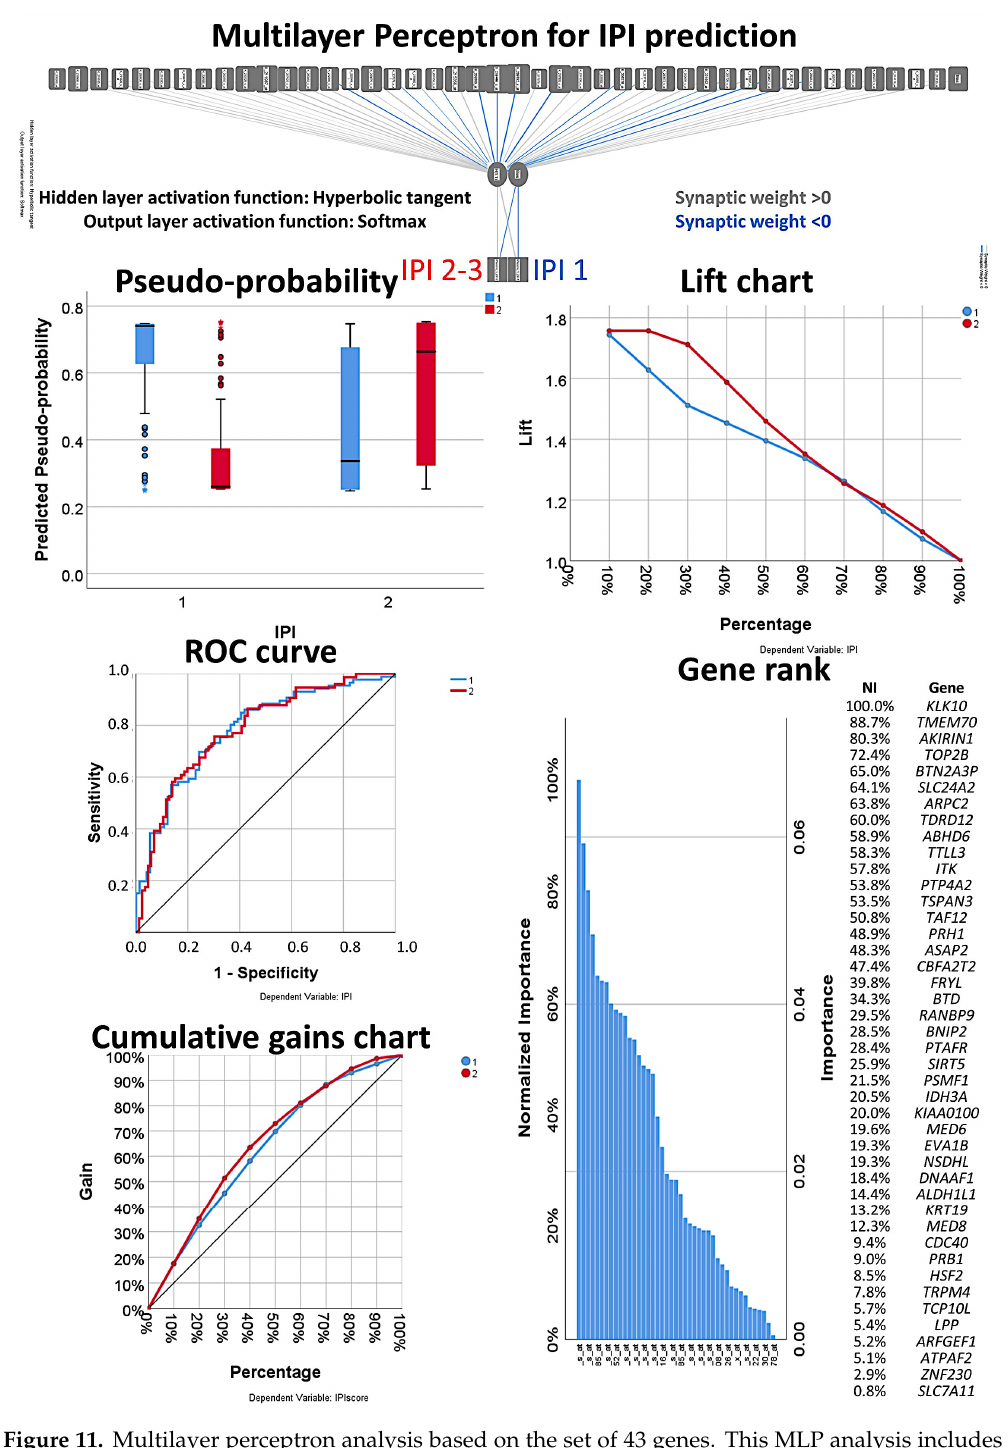
Figure 11. Multilayer perceptron analysis based on the set of 43 genes. This MLP analysis includes only the final set of 43 genes as input variables and predicts the international prognostic index (IPI) of the patients. The quality of the neural network analysis can be confirmed with the ROC curve, and the rank of the genes is shown according to their normalized importance for prediction.